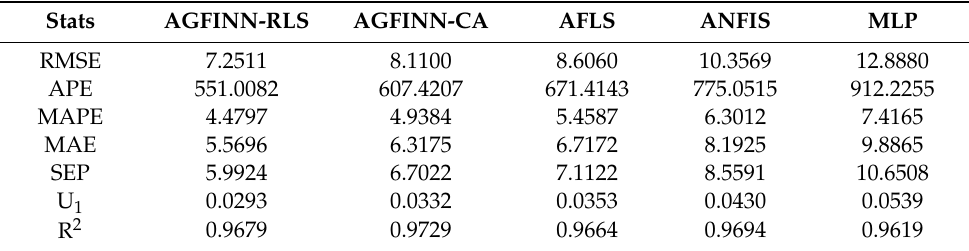
Table 1. Statistical performance for electricity price forecasting models at 22:00—case study 1.